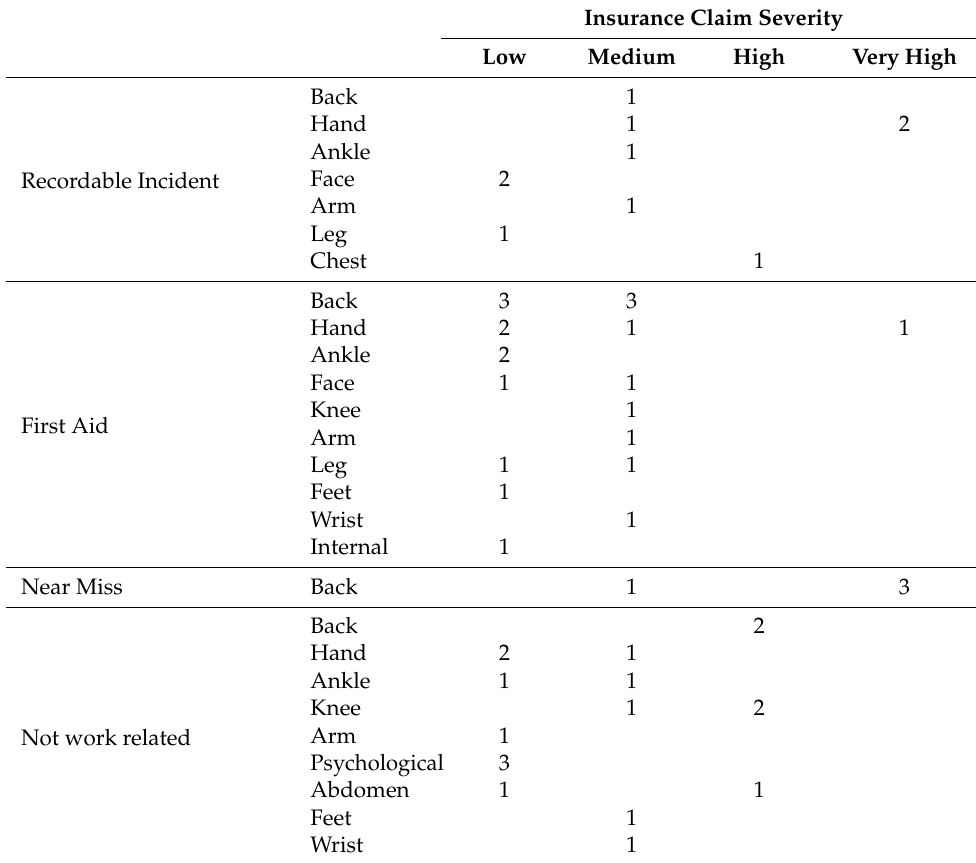
Figure 7. Volume of injuries by body part (coloured by insurance claim severity) beside recordable classification. Table 6. Injuries by body part, severity, and disposition.